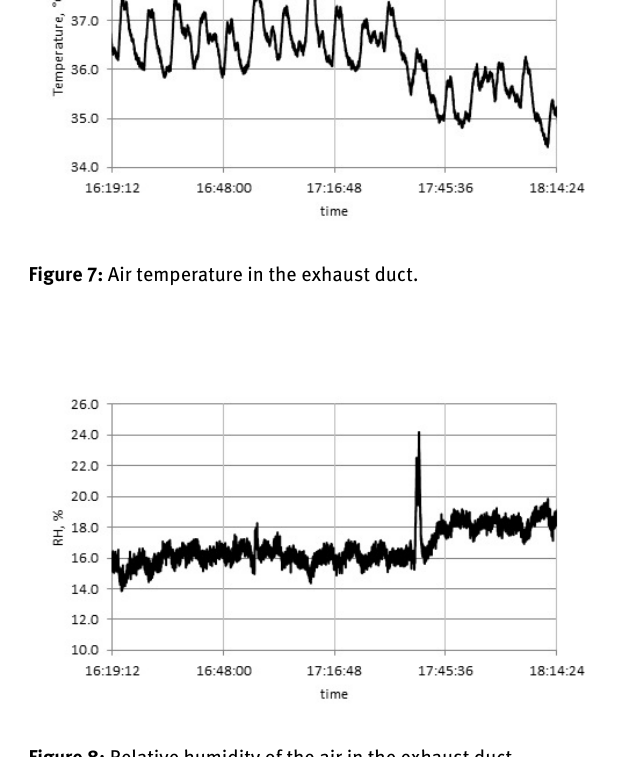
Figure 9: Microjet air purification unit used for the experiment.